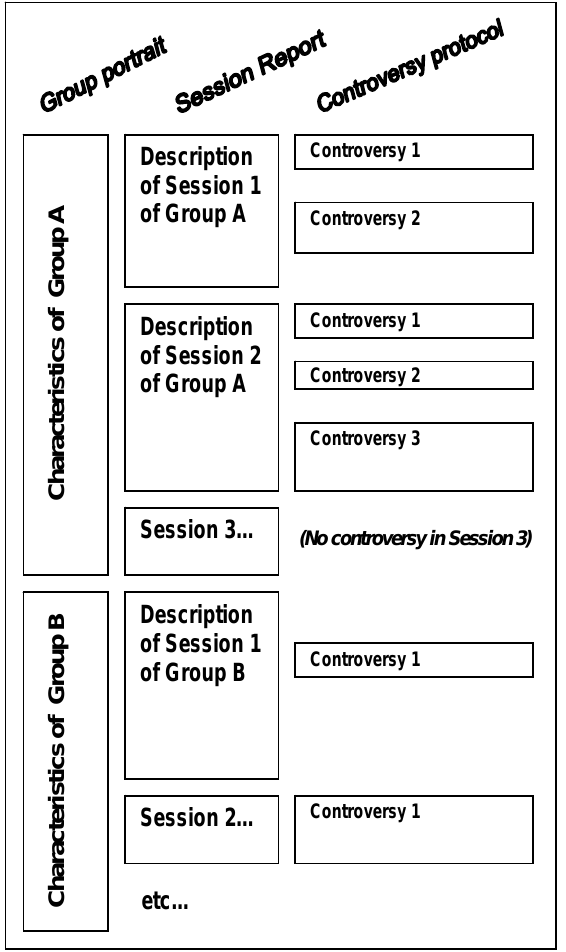
Figure 3: The three-levelled structure of the data from comparative participant